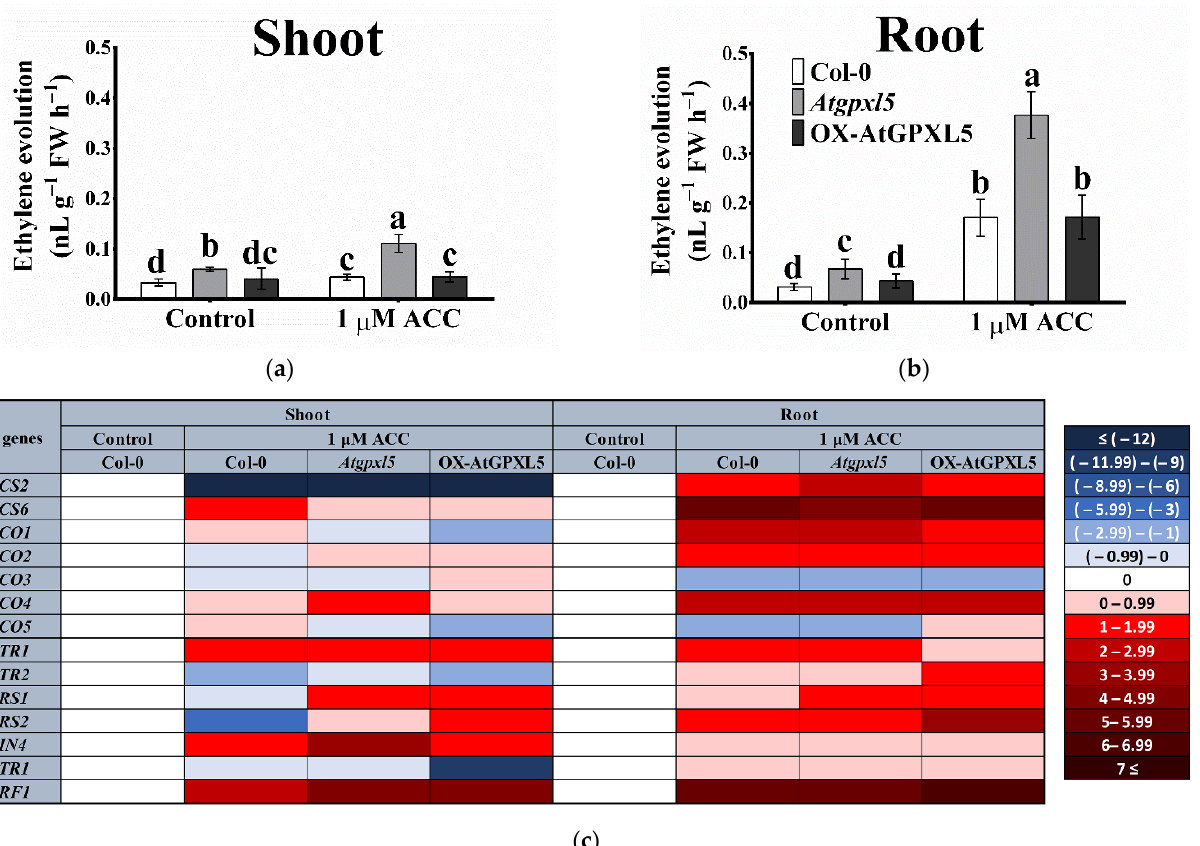
Figure 4. Effect of exogenous application of ACC on ET evolution ( a , b ) and relative expression of genes related to ET biosynthesis and signalling, such as ACS2 , ACS6 , ACO1 , ACO2 , ACO3 , ACO4 , ACO5 and ETR1 , ETR2 , ERS1 , ERS2 , EIN4 , CTR1 , ERF1 ( c ), in the shoots ( a ) and roots ( b ) of 6-week-old Arabidopsis thaliana wild type (Col-0), Atgpxl5-1 insertional mutant ( Atgpxl5 ) and AtGPXL5-overexpressing (OX-AtGPXL5) plants under control conditions and treated with 1 μM ACC for 24 h. The actin2 (At3g18780) gene was used as internal control, data were normalised to the control wild-type values (1) and presented on a log2-scale as a heatmap. The mean 2 (−ΔΔCt) data of RT-qPCR analysis are shown in Supplementary Table S1; n = 3. Red colours show activation, while blue colours show repression, according to the colour scale bar. Abbreviations: ACC — 1-aminocyclopropane-1-carboxylic acid; ACO — ACC oxidase; ACS — ACC synthase; CTR — constitutive triple response; EIN — ethylene insensitive; ERS — ethylene response sensor; ETR — ethylene triple response.